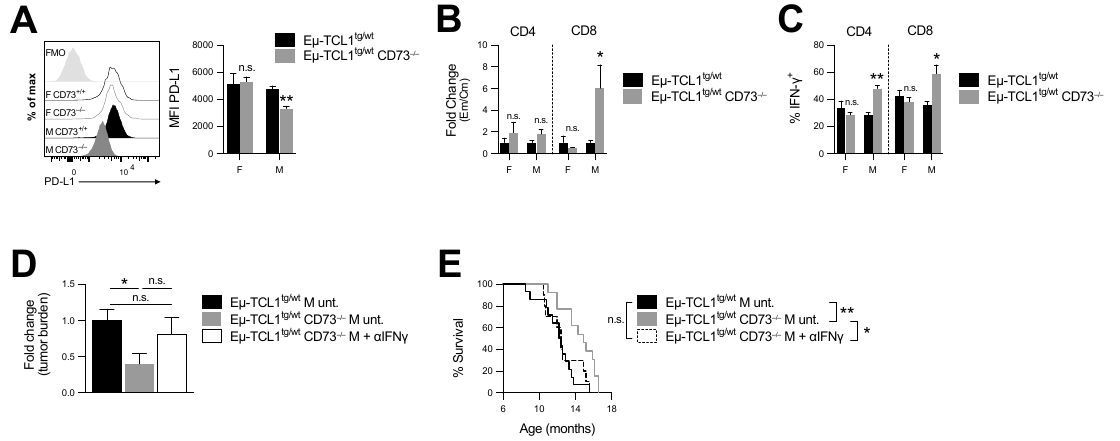
Figure 4. CD73 − / − E µ -TCL1 tg/wt males display increased antitumor immunity and IFN- γ neutral- ization abrogates their prolonged survival. Spleens’ compositions of 8-month-old E µ -TCL1 tg/wt and E µ -TCL1 tg/wt CD73 − / − male and female mice were analyzed by cytometry. ( A ) Analysis of PD-L1 expression levels (MFI) on splenic leukemic CLL (CD5 int B220 int ) cells (M E µ -TCL1 tg/wt n = 7; M E µ -TCL1 tg/wt CD73 − / − n = 8; F E µ -TCL1 tg/wt n = 8; F E µ -TCL1 tg/wt CD73 − / − n = 7). ( B ) Fold change in ratios of effector memory (Em: CD44 + CD62L - ) to central memory (Cm: CD44 + CD62L + ) CD4+ and CD8+ (gated on live CD3+) splenic T cells in E µ -TCL1 tg/wt and E µ -TCL1 tg/wt CD73 − / − (M E µ -TCL1 tg/wt n = 17; M E µ -TCL1 tg/wt CD73 − / − n = 19; F E µ -TCL1 tg/wt n = 9; F E µ -TCL1 tg/wt CD73 − / − n = 10). ( C ) Percentages of IFN- γ + CD4 and CD8 T cells from 8-month-old E µ -TCL1 tg/wt and E µ -TCL1 tg/wt CD73 − / − splenocytes stimulated in vitro with PMA/ionomycin for 6h (M E µ -TCL1 tg/wt n = 5; M E µ -TCL1 tg/wt CD73 − / − n = 5; F E µ -TCL1 tg/wt n = 6; F E µ -TCL1 tg/wt CD73 − / − n = 6). ( D ) Fold change in peripheral disease burden relative to untreated E µ -TCL1 tg/wt mice and ( E ) survival of E µ -TCL1 tg/wt CD73 − / − males treated with anti-interferon gamma ( α IFN γ ; n = 10) compared to historical untreated (unt.) E µ -TCL1 tg/wt ( n = 14) and E µ -TCL1 tg/wt CD73 − / − ( n = 13) controls. Means +/ − SEM are shown (* p < 0.05; ** p < 0.01 by Mann–Whitney test ( A – C ), 1-way ANOVA ( D ) and log-rank ( E )). FMO, fluorescence minus one; F, female; M, male; Em, effector memory; Cm, central memory; unt., untreated; n.s.,